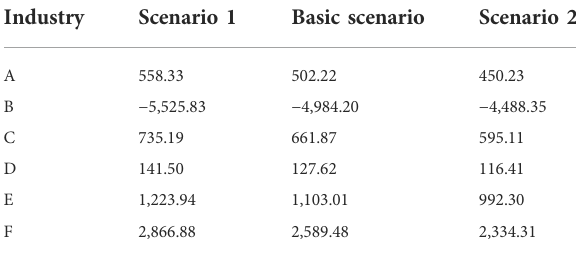
TABLE 7 Transfer amount of carbon emission permit in the three scenarios (unit: million tons).